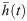
Self-tuned coherent chaos.(A)-(B) Comparison between weak structured connectivity (Left: J1 = 0.8) and stronger structured connectivity (Right: J1 = 15.8) Both with N = 4000. (A) Histogram of values of the coherent mode current, h¯(t). Mild structured connectivity yields coherent fluctuations with a peak at zero and a distribution that appears not far from Gaussian. For stronger structured connectivity the histogram is clearly non-Gaussian and highly bimodal. (B) Top: Sample activity of 10 randomly chosen neurons, ϕi (t) and coherent mode activity, ϕ¯(t). Middle: Speed of network during same epoch of activity, (definition in text). Bottom: Instantaneous population variance of the residual currents δhi (t). For mild structured connectivity, ϕ¯(t) fluctuates around zero (top), speed is roughly constant throughout the trial (middle), residual currents maintain large variance throughout (bottom). On the other hand, for stronger structured connectivity, there is state-switching between bouts of high and low coherent-mode activity (top), these same bouts are associated with vanishing speed (middle), and with small residual currents (bottom). Gray shaded regions show epochs of speed lower than 0.18, which was the lowest instantaneous speed achieved without structured connectivity. (C) Statistical mode (most frequent value) of ∣h¯∣ as a function of J1. The results indicate a crossover to self-tuned coherent chaos, defined by the bimodal peaks of ∣h¯∣ reaching a constant value. The crossover occurs very rapidly and independently of N. Dashed line shows h¯c=ϕ′-1(1g). (D) The statistical mode of ∣h¯∣ as a function of g with fixed J1 = 10 and N = 8000. Dashed line shows h¯c=ϕ′-1(1g). In all other panels g = 2.